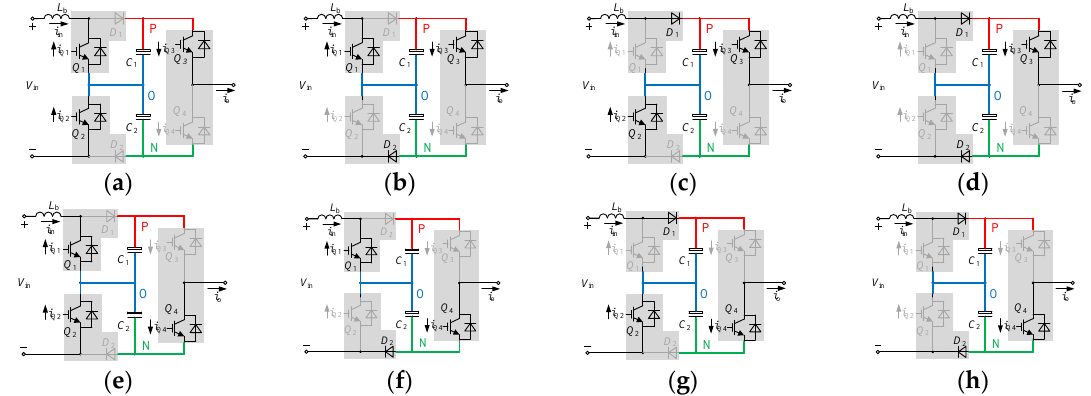
Figure 4. Flow path of back-to-back converter. ( a ) Path A. ( b ) Path B. ( c ) Path C. ( d ) Path D. ( e ) Path E. ( f ) Path F. ( g ) Path G. ( h ) Path H.